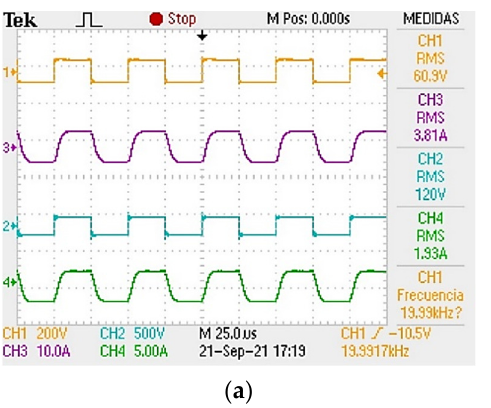
The comparison between voltages and currents of both MFTs prototypes at full